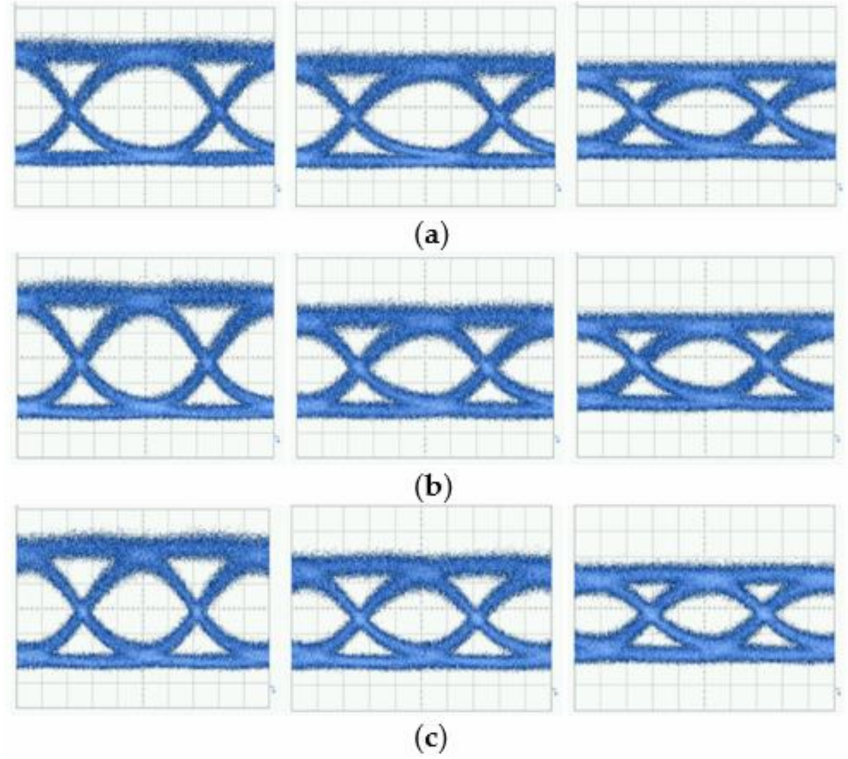
Figure 4. Representative eye diagrams at ( a ) 22, ( b ) 25, and ( c ) 28 Gb/s (from left to right: best, intermediate, worst). Unit for the horizontal axis: 8 ps/div; unit for the vertical axis: 20